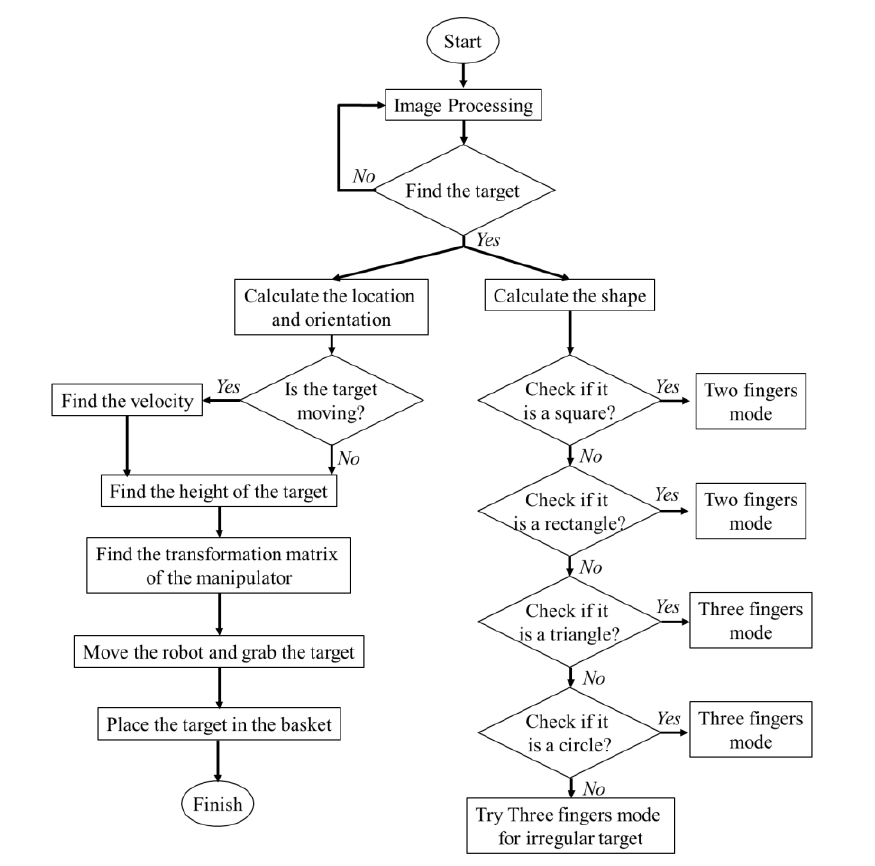
Figure 19. Flowchart depicting the grasping operation of the system.